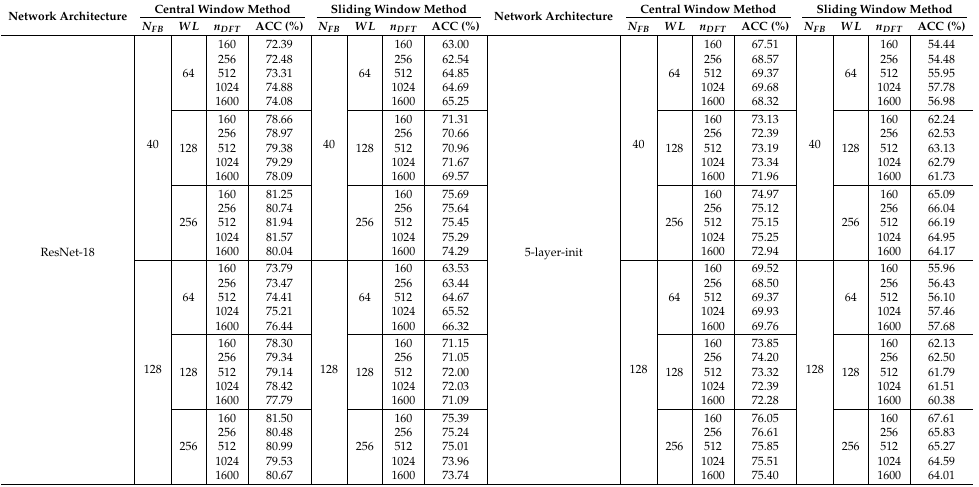
Table 2. Spectrogram-window classification accuracy (ACC) on the TIMIT dataset for different tested architectures and different combinations of speech preprocessing parameters.